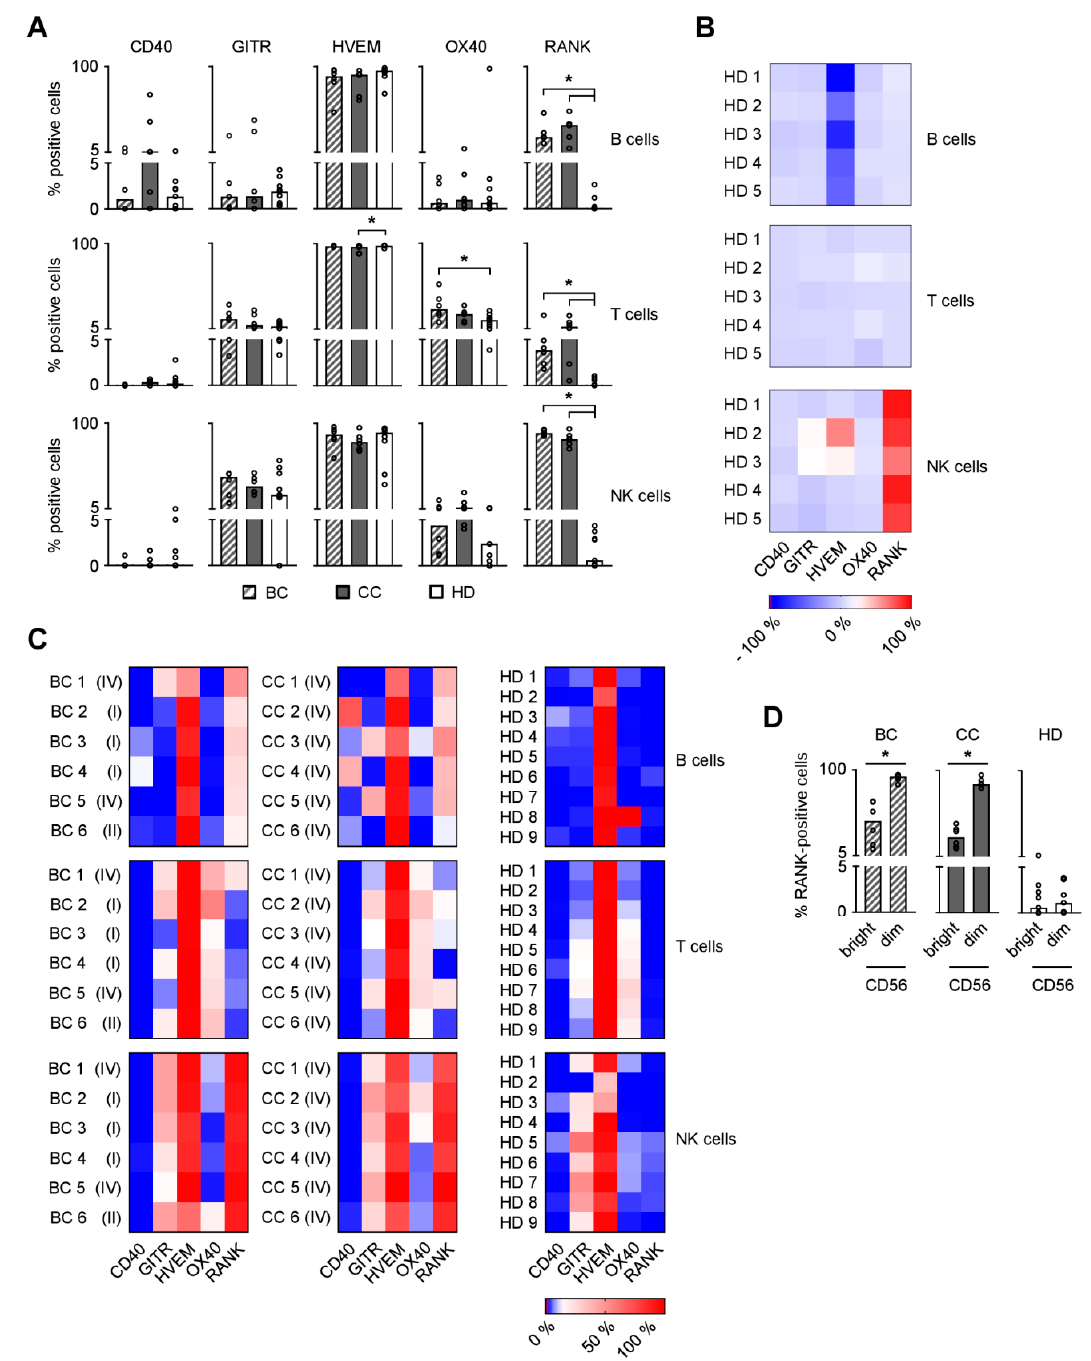
Figure 1 . Expression of TNFR family molecules on PBMC subpopulations. ( A , C , D ) CD40, GITR, HVEM, OX40, and RANK surface expression on PBMC subpopulations from BC and CC patients and HD were investigated by flow cytometry ( n = 6, 6, and 9, respectively). ( A ) The percentage of surface expression is indicated. ( B ) PBMC from five HD were freshly isolated or cultured without treatment for three days and CD40, GITR, HVEM, OX40, and RANK surface expression was determined by flow cytometry. Results were comparatively analyzed as follows: “percent surface expression of cultured PBMC” − “percent surface expression of freshly isolated PBMC”. The net modulation is depicted as heatmap. ( C ) Heatmap analysis of the surface expression profiles among PBMC of individual patients (disease stage as described in Table 1) and HD investigated. ( D ) The percentage of RANK surface expression on CD56 bright and CD56 dim NK cell subsets is displayed. ( A , D ) Median values of the respective group are depicted. Statistically significantly different results ( p < 0.05) are indicated by *.